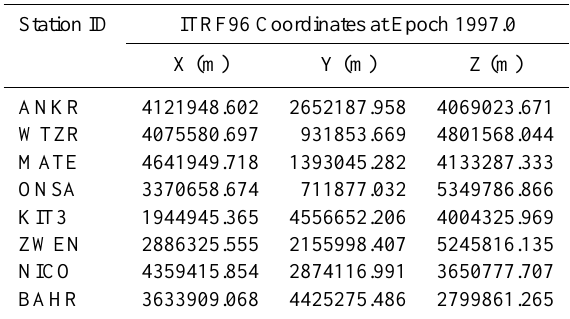
Table 2. Coordinates of IGS Stations of TNFGN.